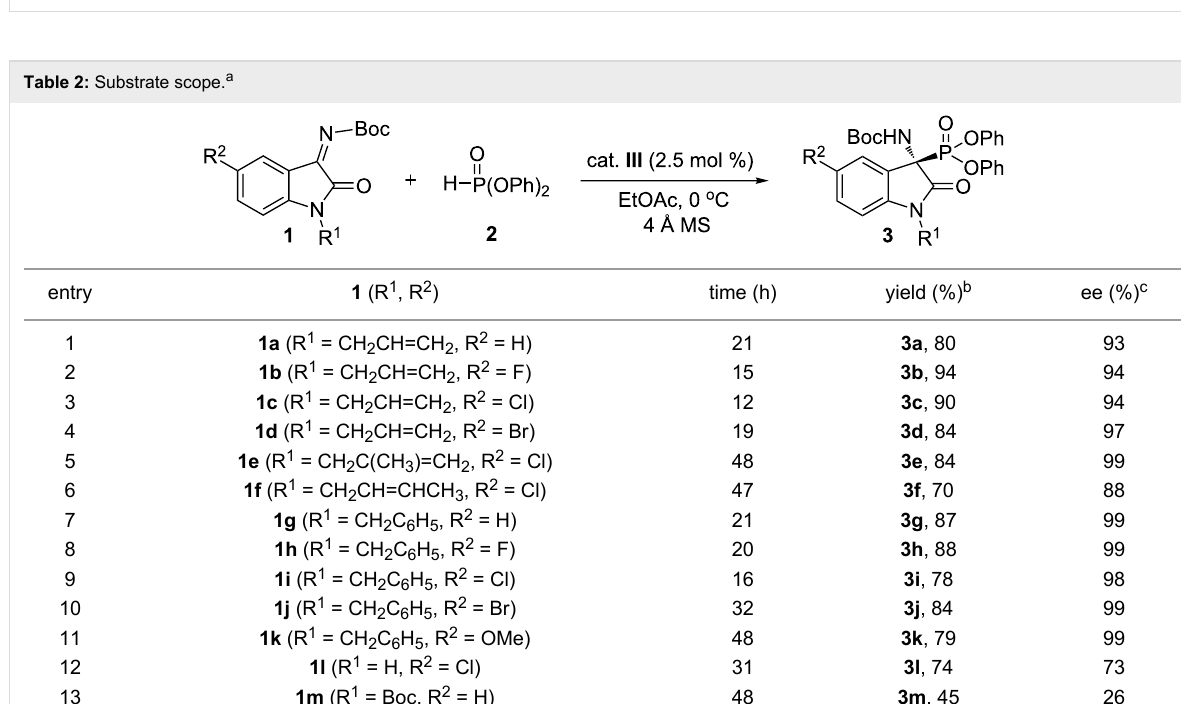
a Reaction conditions: ketimines ( 1 , 0.3 mmol), diphenyl phosphonate ( 2 , 0.45 mmol), catalyst ( III , 7.5 μ mol), EtOAc (3.0 mL) at 0 °C in the presence of 150 mg molecular sieve. b Isolated yield. c Enantiopurity was determined by HPLC analysis using Chiralpak IA (for 3f ), IB (for 3a ), IC (for 3b – e , 3g – j ), and AD-H (for 3k , 3l )